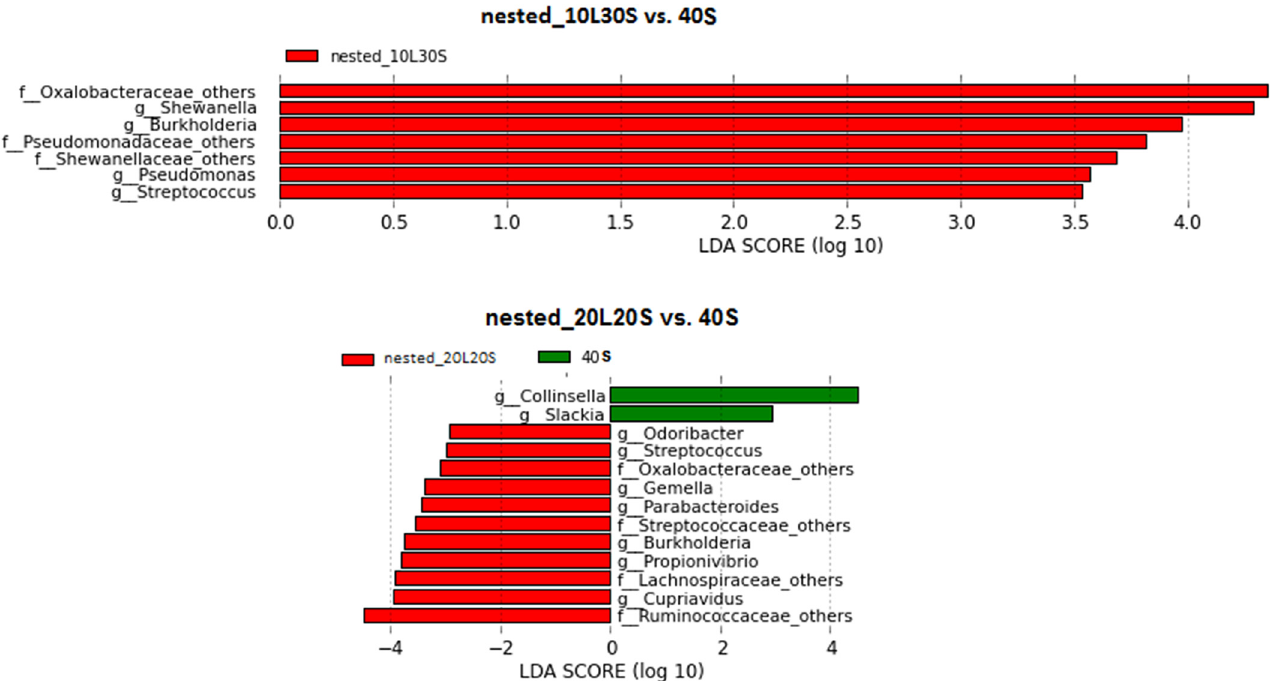
Fig 5. Histogram of the LDA scores computed for microbial genera differentially abundant between nested and standard PCRs in stool samples. The taxa shown in red are the ones with significantly higher abundance by nested PCRs while the taxa shown in green are the ones with significantly higher abundance by standard PCR. The g or f before the taxon name means genus or